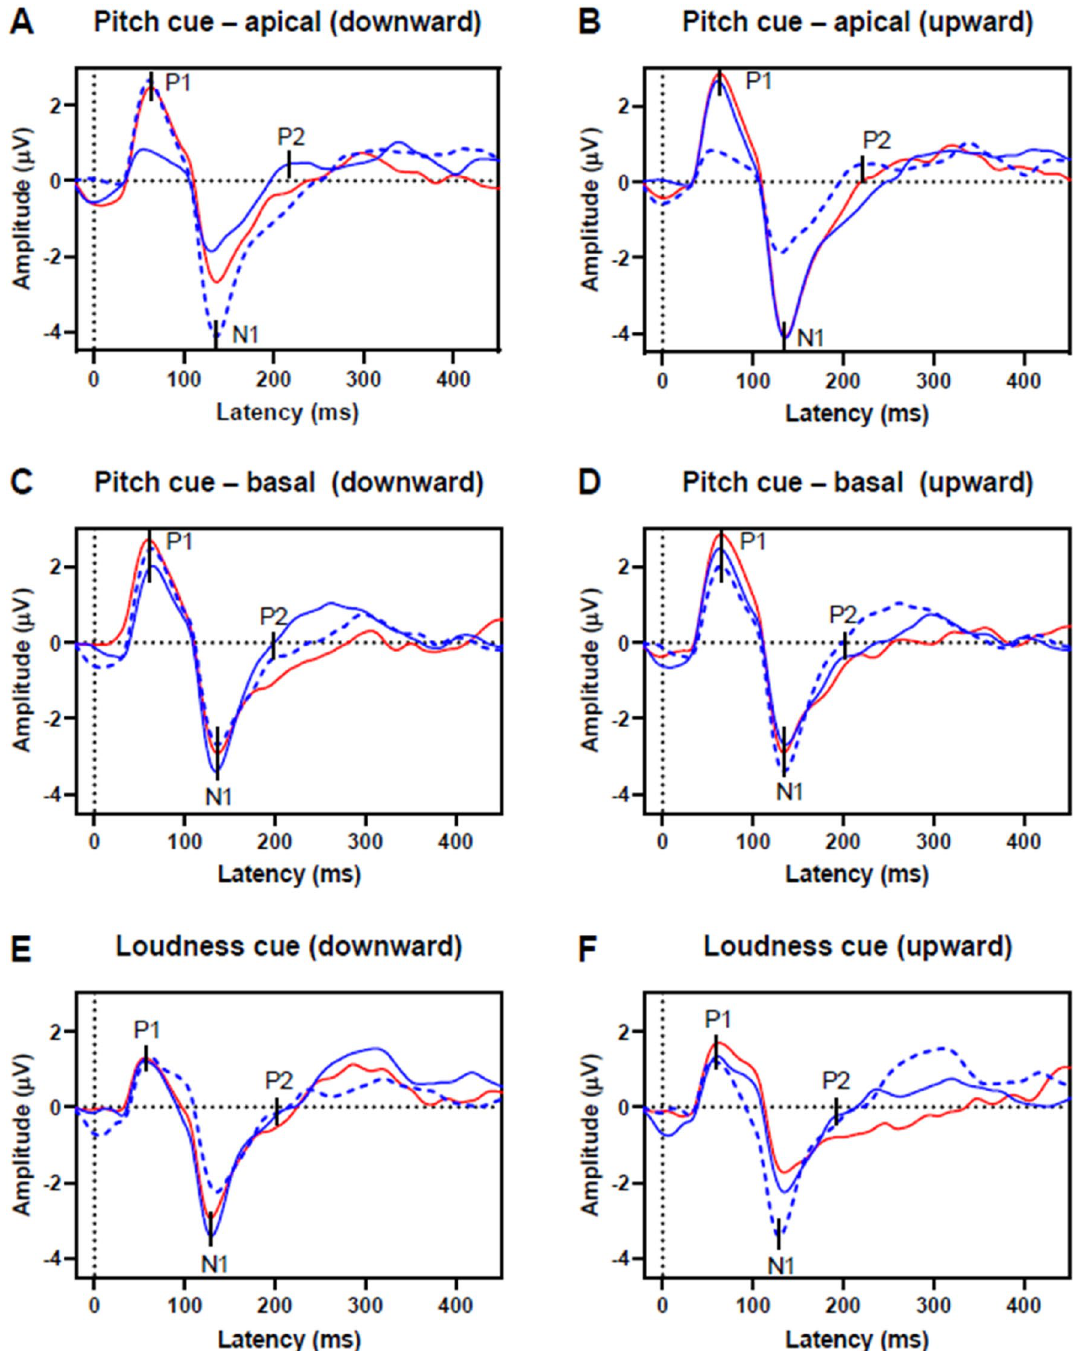
Figure 2. EEG responses for standard (blue) and deviant (red) stimulation as averages over all participants (n = 17). The deviant stimuli differed from the standard stimuli in pitch at an apical CI electrode ( A , B ), in pitch at a basal electrode ( C , D ) or loudness ( E , F ). For comparison the interblock standard response waveform (blue dashed line) is depicted that follows the physical identical standard stimuli to the deviant